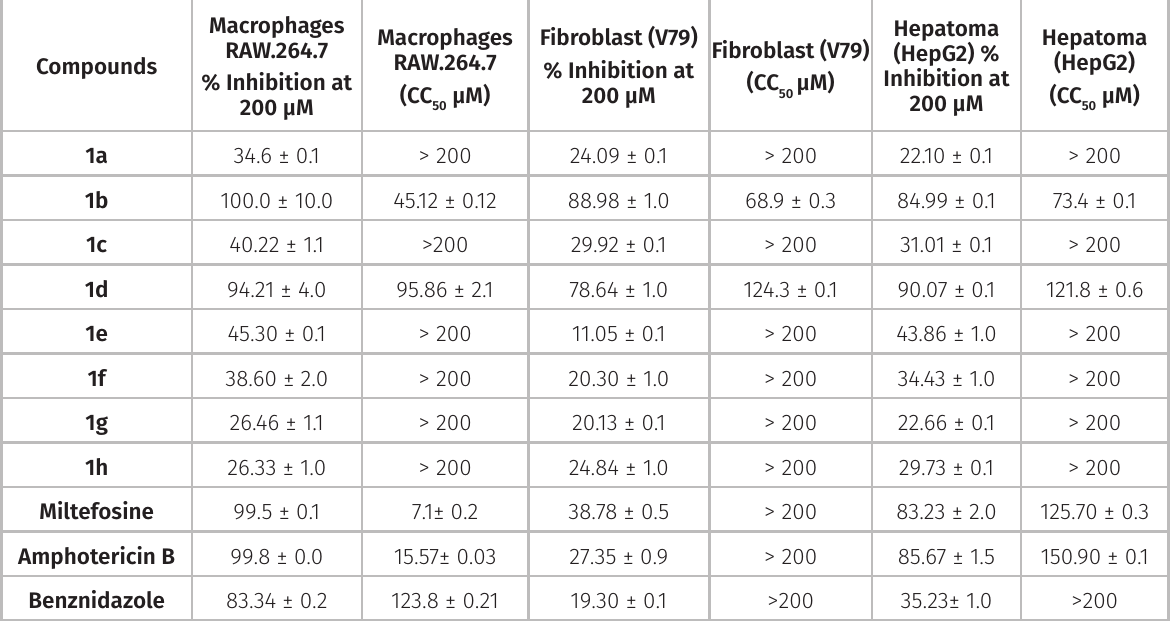
Table II. Cytotoxicity results were expressed in percentage of growth inhibition at the highest concentration (200 µM) for the assays and in CC (capacity to inhibit growth by 50%) promoted by the compounds against RAW.264.7 50 macrophage cells, V79 fibroblasts and liver cells HepG2 respectively. Macrophages Compounds